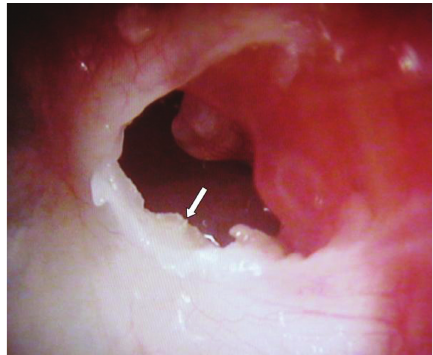
Figure 2: Otoendoscopic view of the marginal perforation of the left ear. White keratin debris appears on the medial surface of the tympanic membrane from the perforation (arrow: white keratin debris).